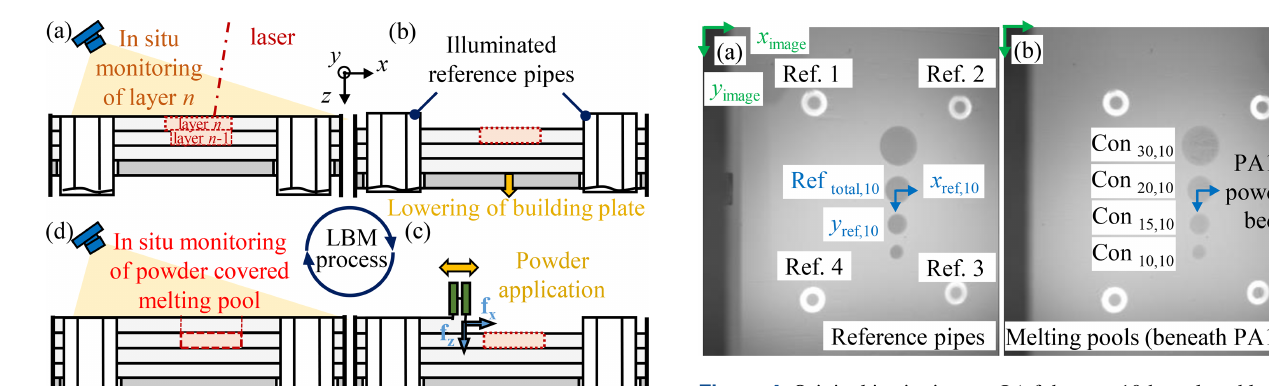
Figure 4. Original in situ images I (of the n = 10th analysed layer) with illuminated reference pipes (a) after energy input of the laser and (b) after powder